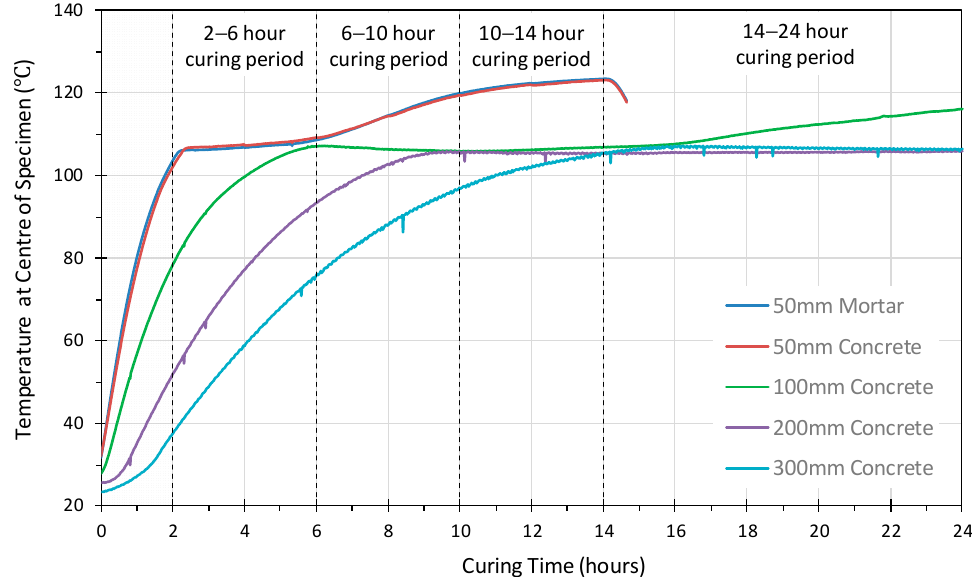
Figure 2. The temperature development at the center of the geopolymer mortar and concrete specimens.